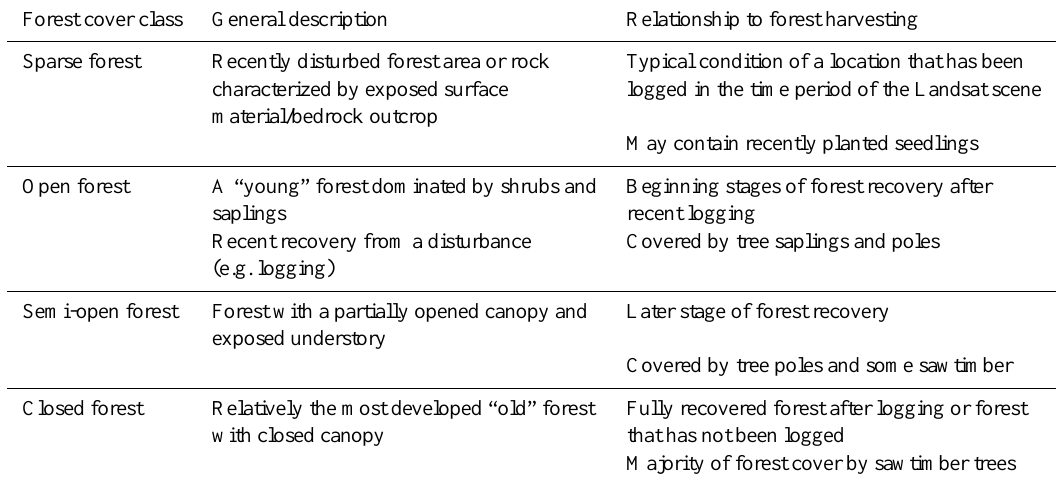
Table 1. Description for forest cover classes. Forest cover class General description Sparse forest Typical condition of a location that has